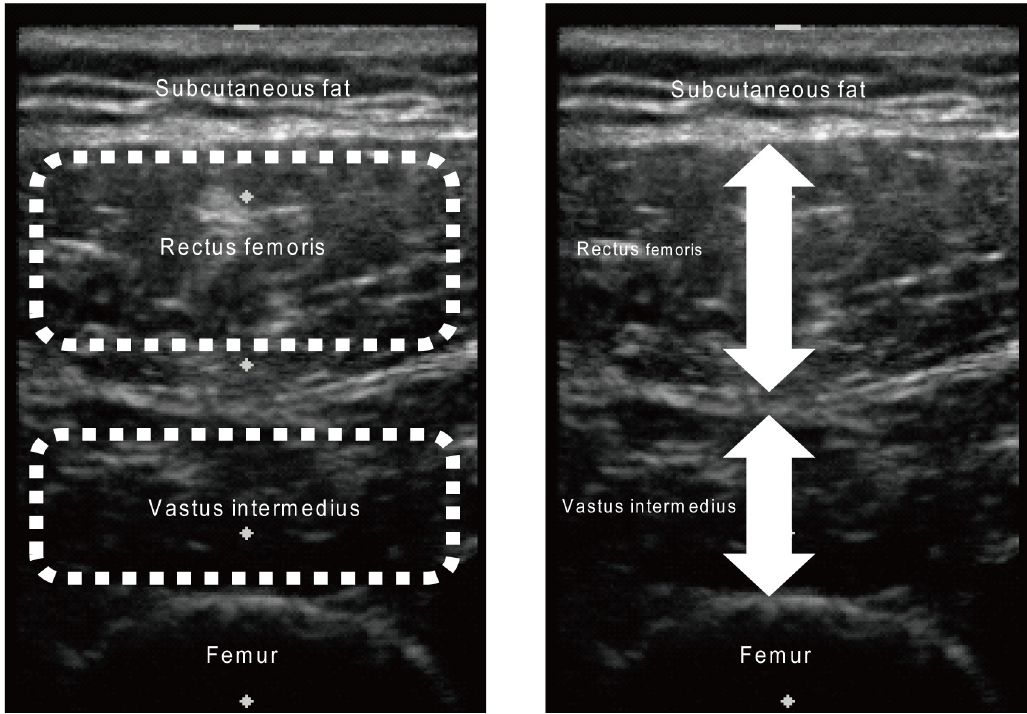
Fig 1. Measurement areas of echo intensity (dashed lines) and muscle thickness (arrows) of the rectus femoris and vastus intermedius.